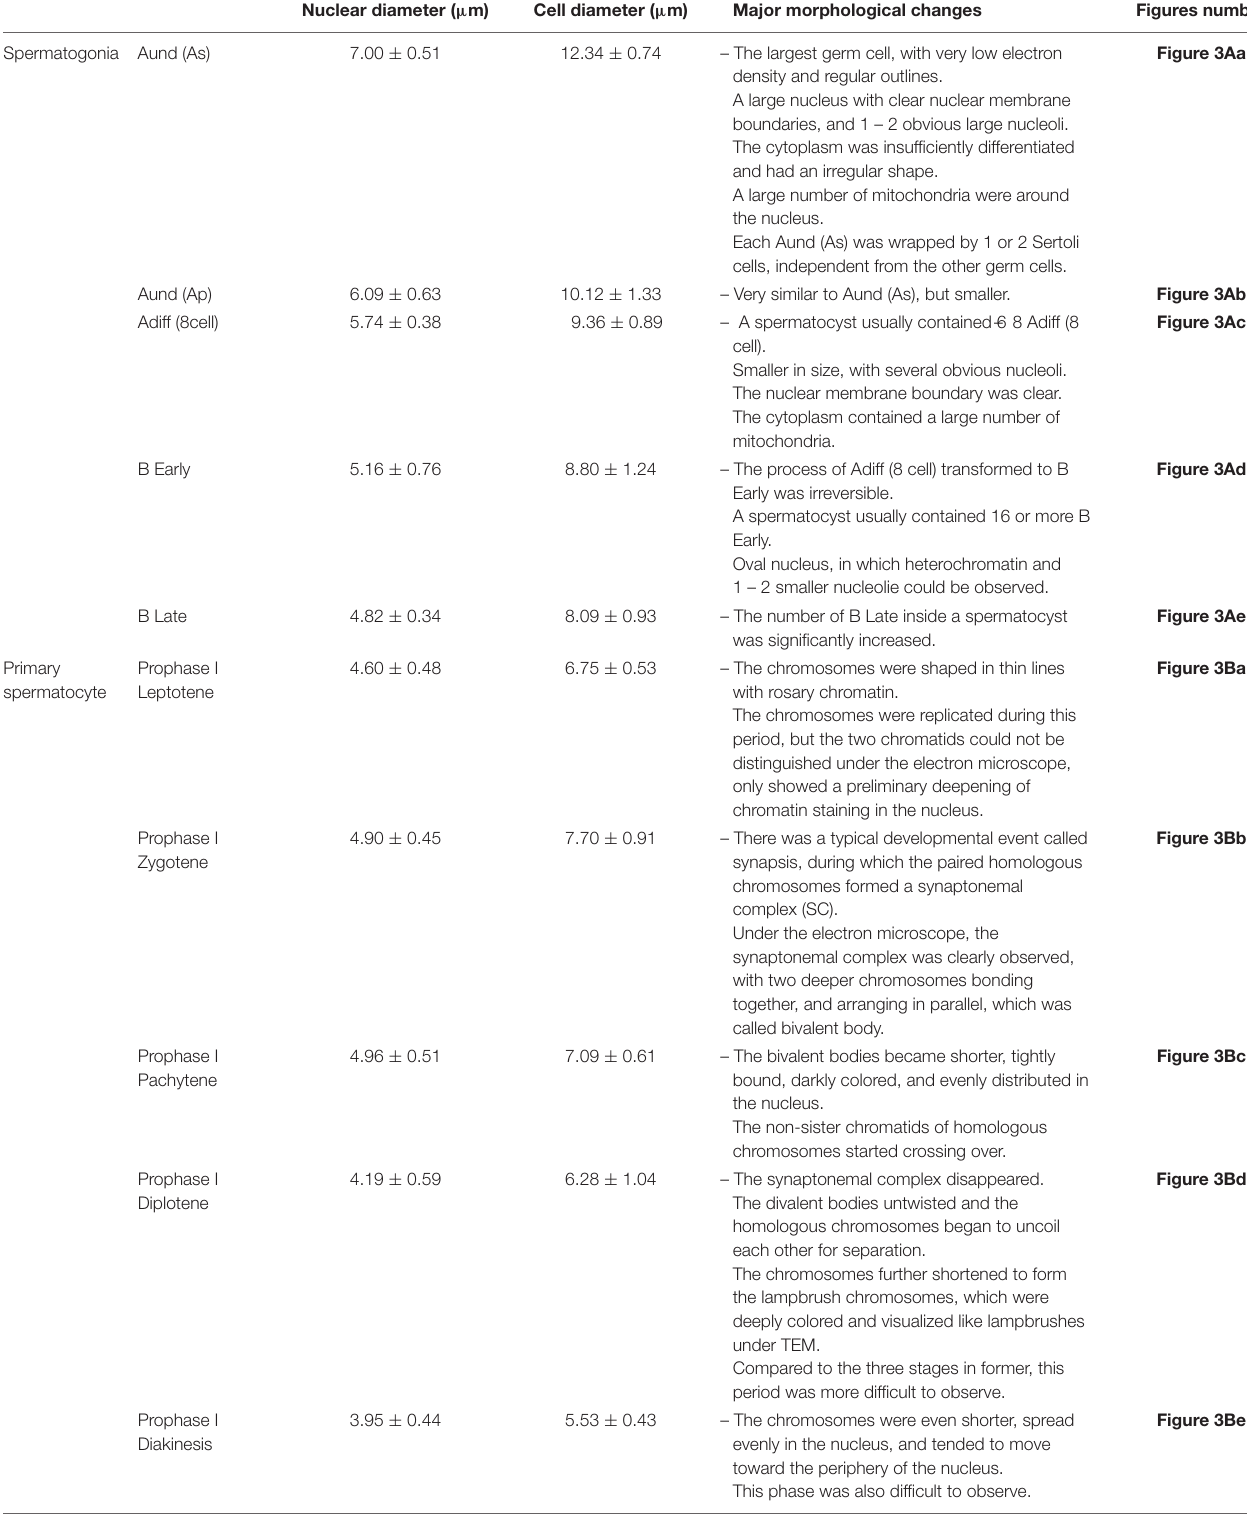
TABLE 2 | Morphological changes, cell diameter, and nuclear diameter of germ cells at different stages. Nuclear diameter ( µ m) Cell diameter ( µ m) Major morphological changes Spermatogonia Aund